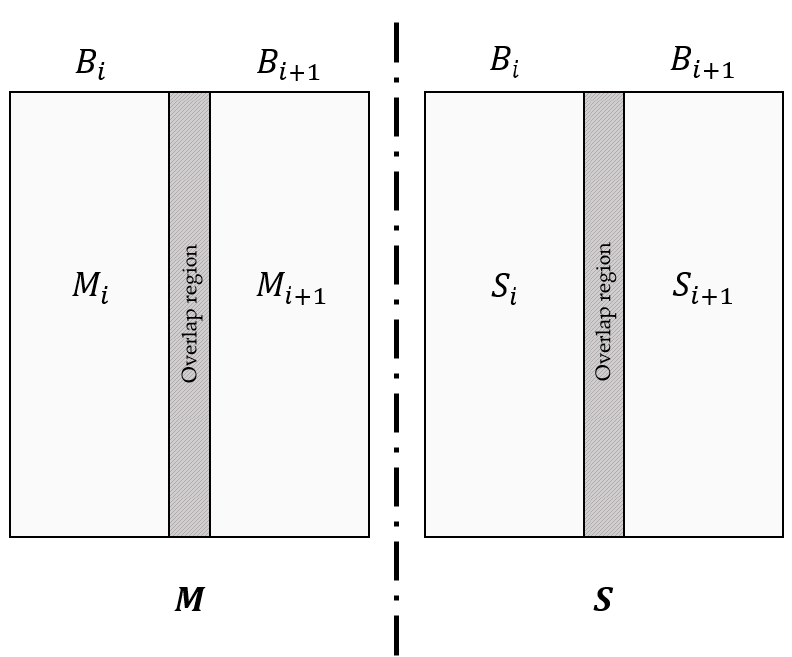
Figure 18. Scheme of two TOPSAR master ( 𝑴 ) and slave ( 𝑺 ) acquisitions that are related to two contiguous bursts 𝐵 𝑖 and 𝐵 𝑖+1 .